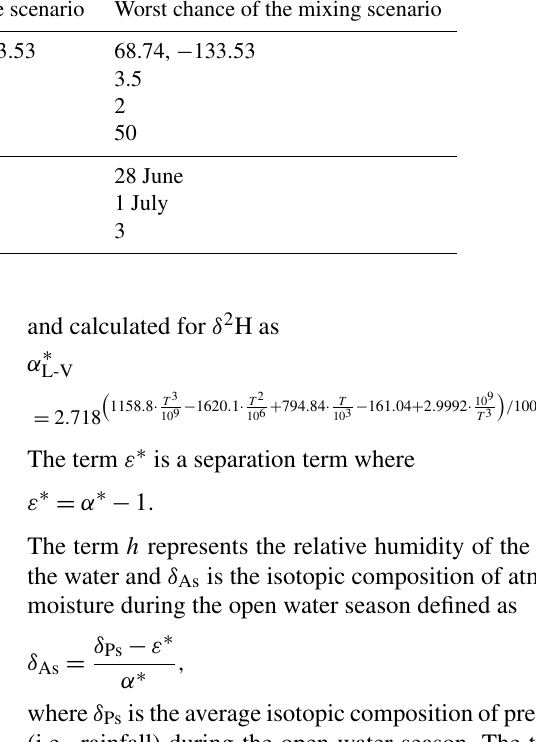
Table A1. Input parameters and results for the two scenarios used to evaluate the mixing conditions of lakes during the ice-off period.